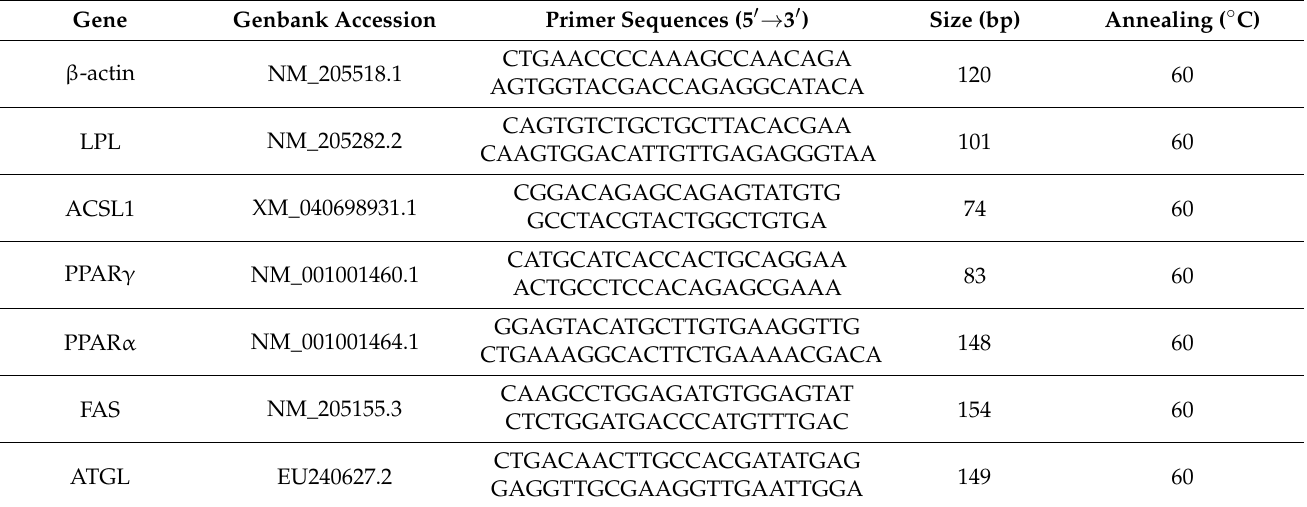
Table 2. Primers used in the study.